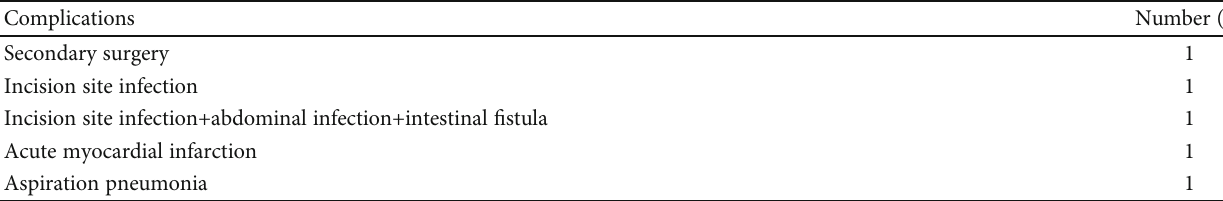
Table 3: Complications after surgery.